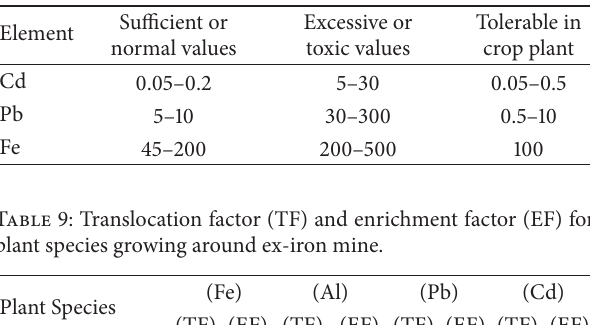
Table 8: Normal, excessive, and toxic values of metals in mature leaf tissue and vegetation generalized for various species ( 𝜇 g/g).